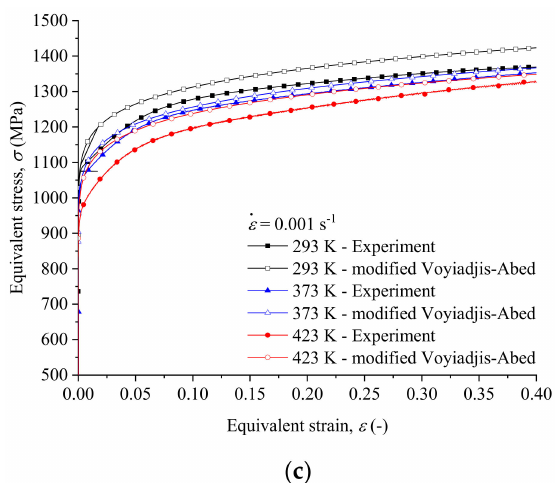
Figure 14. Comparison of the modified Voyiadjis–Abed model and the experimental data: ( a ) for different strain rates, at T 0 =293 K; ( b ) for different temperatures, at ˙ ε ~1100 s − 1 ; and ( c ) for different temperatures, at ˙ ε = 0.001 s − 1 .